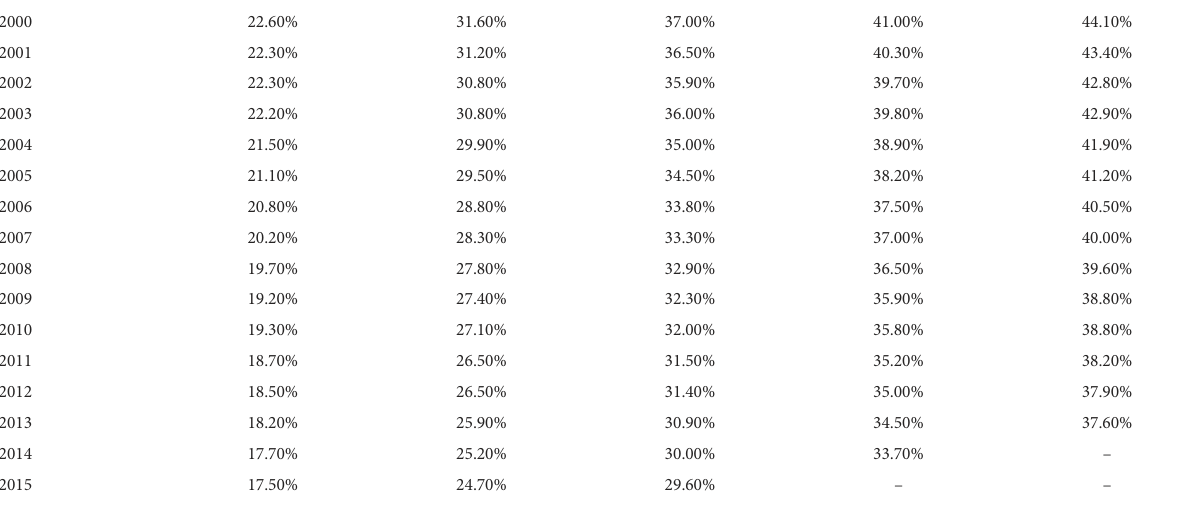
TABLE 6 Mortality rate according to the year of